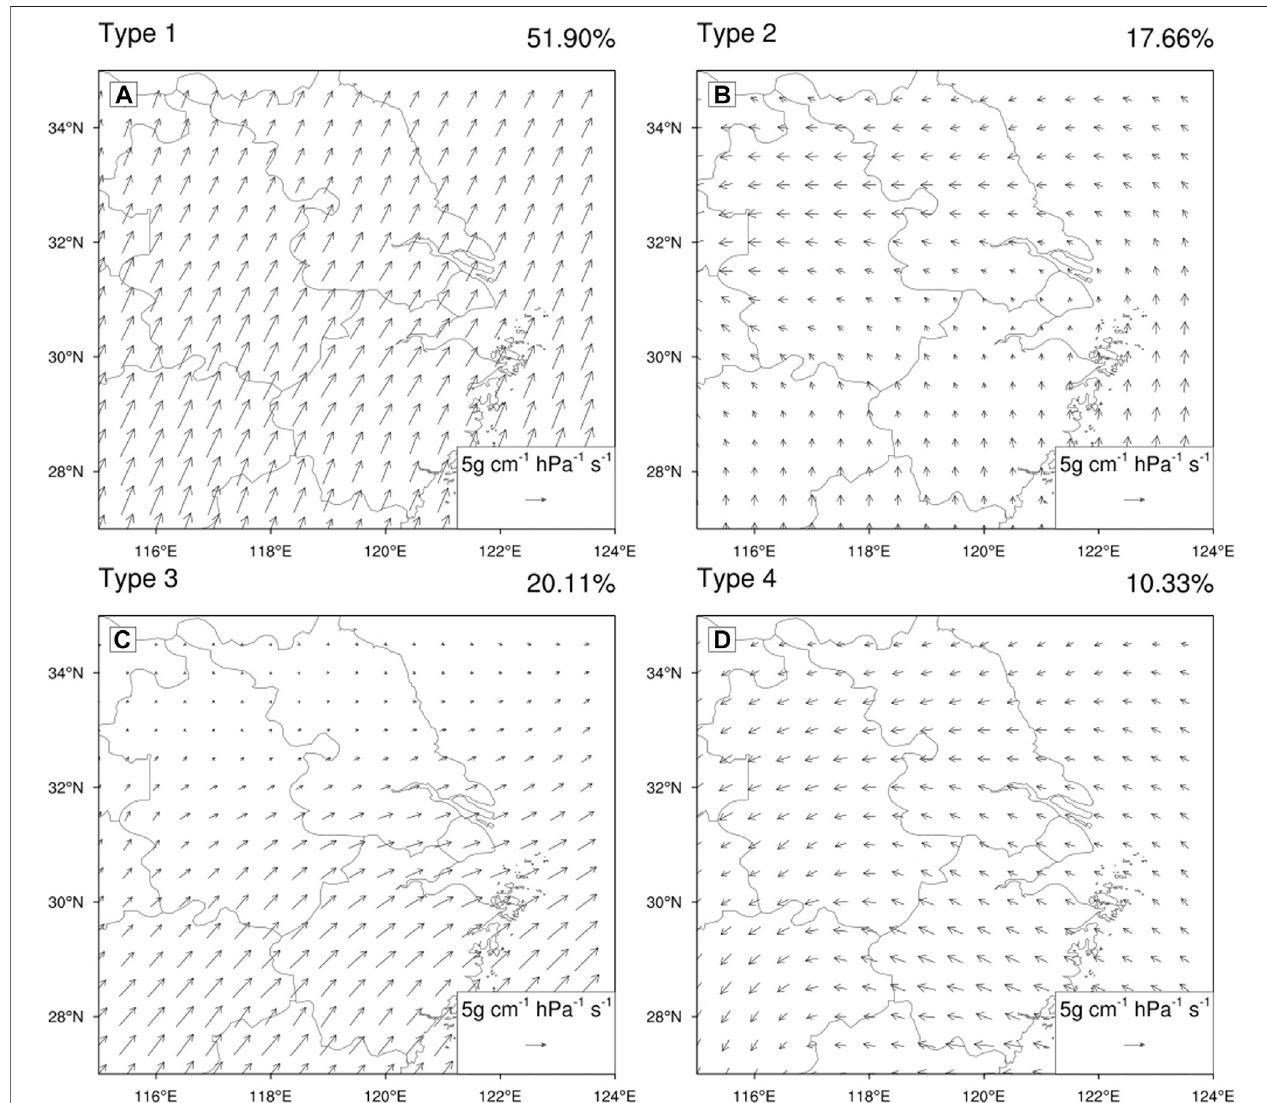
FIGURE 11 | The 850-hPa water vapor fl ux (WVF (cid:2) V × q/g , where q is speci fi c humidity, g is gravitational acceleration, and V is horizonal wind; vectors; see scale arrow in the bottom right in units of 5 gcm − 1 hPa − 1 s − 1 ) under four SWPs: (A) Type 1; (B) Type 2; (C) Type 3; and (D) Type 4.